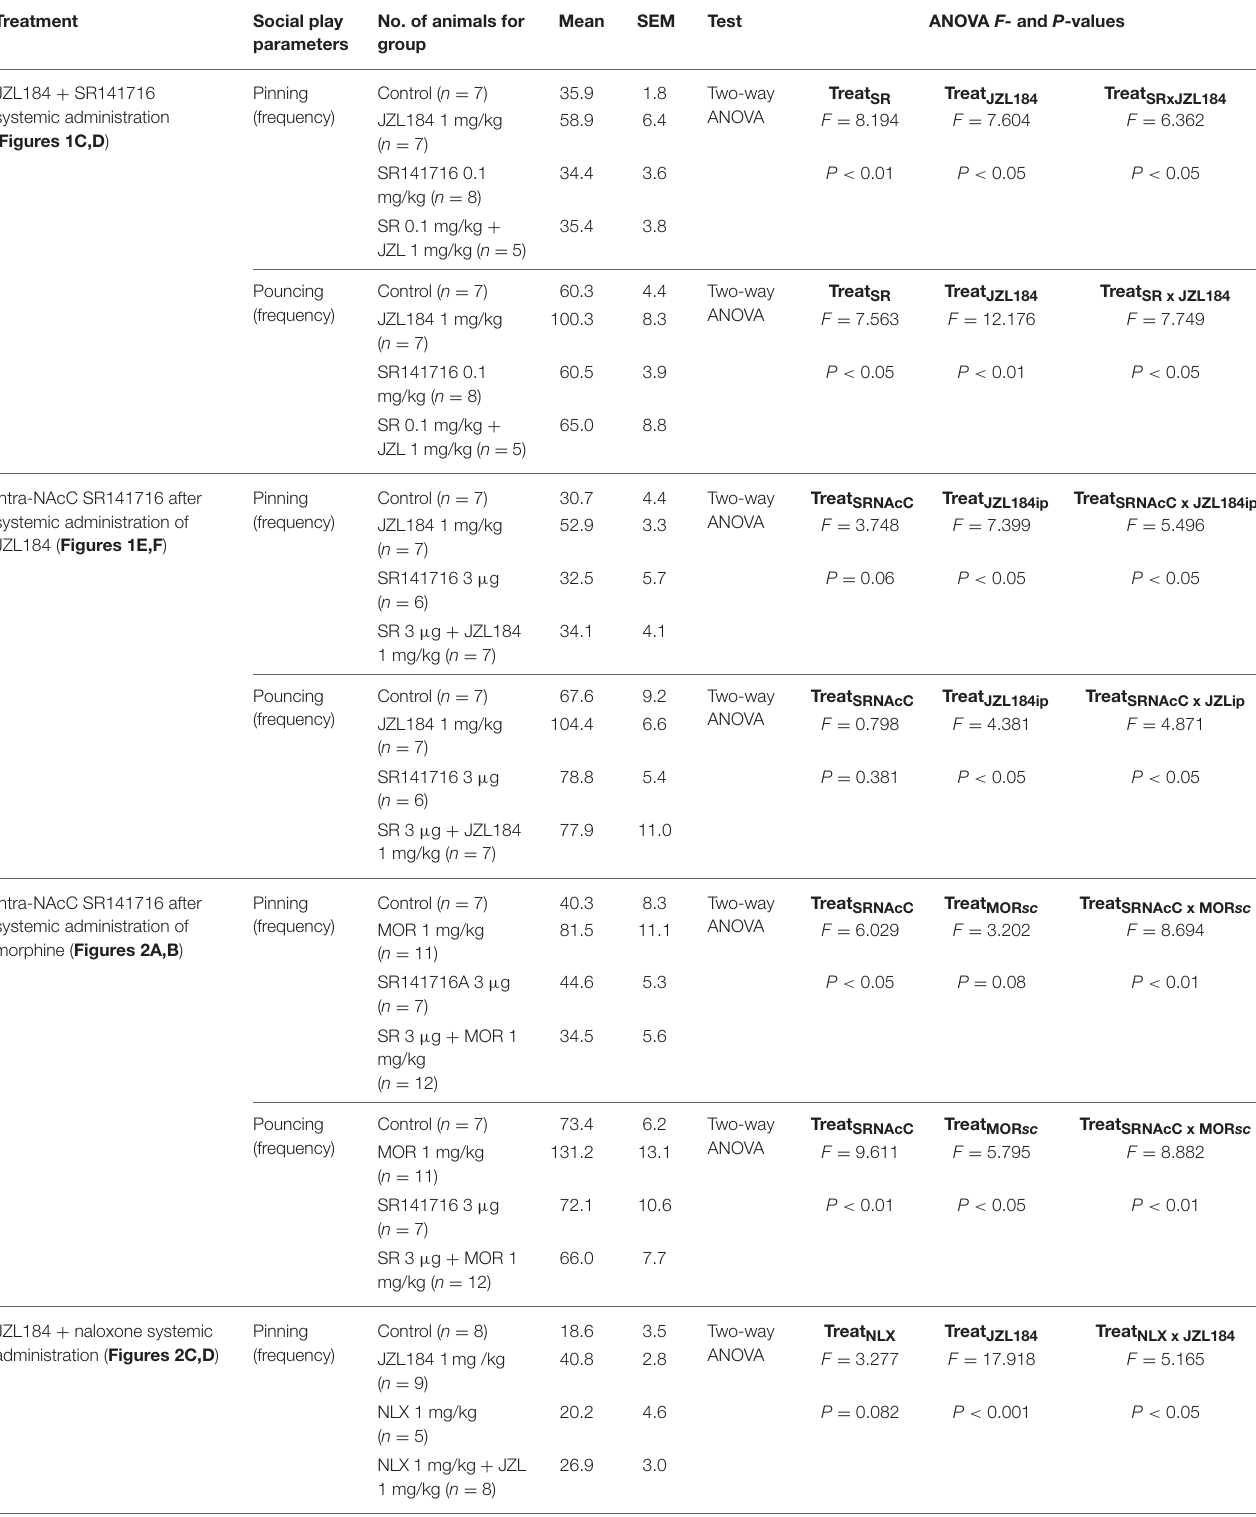
TABLE 3 | Statistical report of social behavior parameters in adolescent rats and mice. Treatment Social play No. of animals for Mean SEM Test ANOVA F- and P parameters group